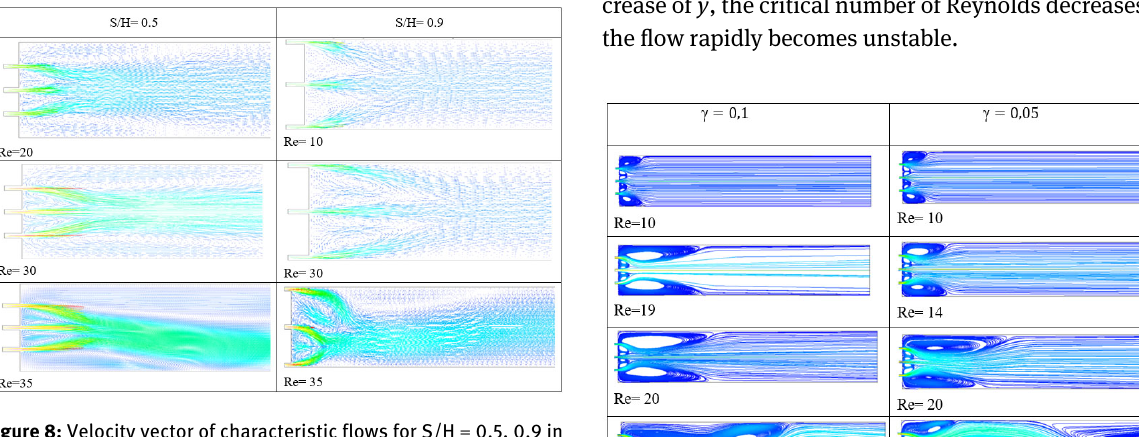
Figure 8: Velocity vector of characteristic flows for S/H = 0.5, 0.9 in three jets